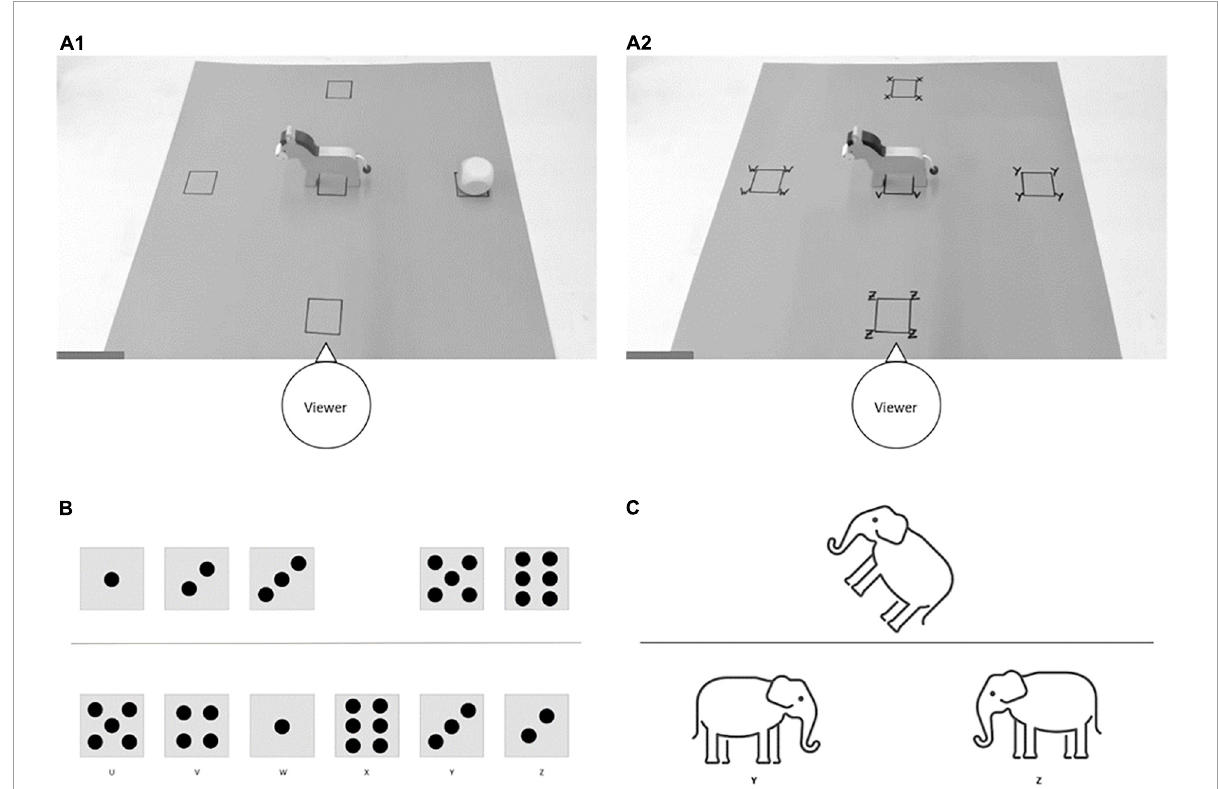
FIGURE1 Stimulus material of tasks used. (A1) Set up to assess children’s production of spatial terms. Children were asked, “Where is the cube?” An egocentric answer would be “to the right,” while an allocentric answer would be “behind” (the donkey). (A2) Set up to assess children’s comprehension of spatial terms. The experimenter told the children where to put the cube and asked them to point to the given position. (B) Exemplary stimulus of the task to identify missing dice patterns of a series. (C) Exemplary stimulus of the task to assess children’s mental rotation